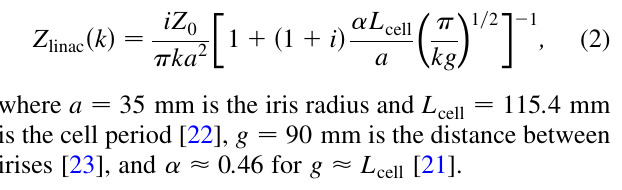
FIG. 2. Bunch compression without collective effects, for an initial parabolic current distribution with rms length of 400 (cid:2) m and 3- keV Gaussian energy spread, according to ELEGANT simulations of 100 000 particles. In the phase-space plots, the longitudinal coordinate z is zero at the average electron position, with z > 0 at the tail of the bunch. (a) Initial bunch at 4 MeV. (b) Chirped bunch at the entrance of the BC1 chicane. (c) Bunch after single-stage compression in BC1. (d) Chirped bunch at the entrance of the BC2 chicane. (e) Bunch after full compression in BC2. (f) Dechirped bunch at 1.7 GeV.